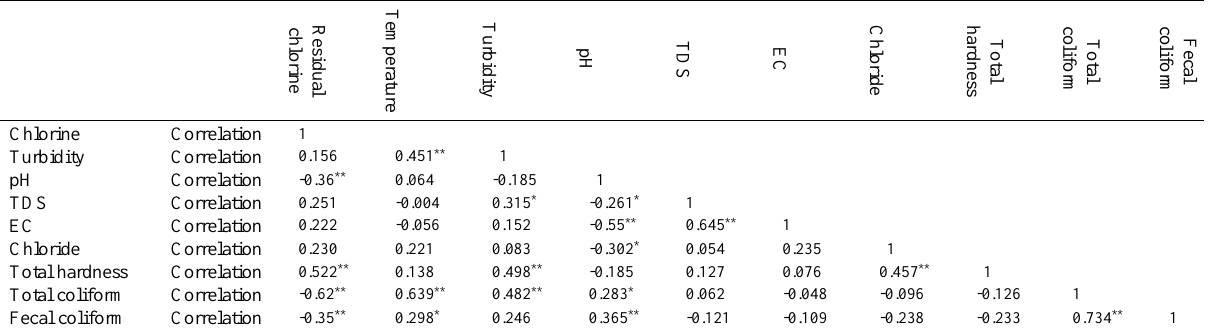
Table 6. Correlation matrix of investigated parameters based on distribution networks (**P<0.01) R e s i du Chlorine Correlation 1 Turbidity Correlation 0.156 0.451 ** 1 pH Correlation -0.36 ** 0.064 -0.185 1 TDS Correlation 0.251 -0.004 0.315 * -0.261 * 1 EC Correlation 0.222 -0.056 0.152 -0.55 ** 0.645 ** 1 Chloride Correlation 0.230 0.221 0.083 -0.302 * 0.054 0.235 1 Total hardness Correlation 0.522 ** 0.138 0.498 ** -0.185 0.127 0.076 0.457 ** 1 Total coliform Correlation -0.62 ** 0.639 ** 0.482 ** 0.283 * 0.062 -0.048 -0.096 -0.126 1 Fecal coliform Correlation -0.35 ** 0.298 * 0.246